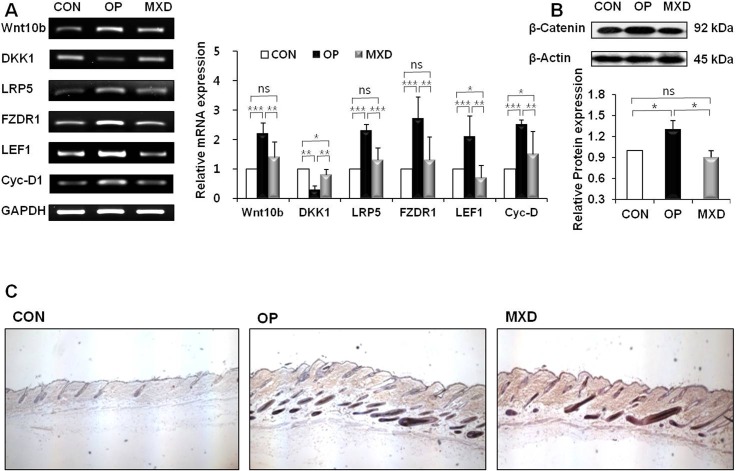
Effect of oleuropein on expression of genes related to hair growth in C57BL/6N mice skin tissue.(A) The Wnt10b, DKK1, LRP5, FZDR1, LEF1, and Cyc-D1 mRNA expression levels were measured by RT-PCR. A representative image of triplicate experiments is shown in the left panel. The right panel shows the intensity of the bands that were densitometrically measured and normalized against the mRNA expression level of GAPDH. (B) The protein level of β-catenin in C57BL/6N mouse skin tissue was determined by western blotting. The lower panel shows the intensity of the bands that were densitometrically measured and normalized against the protein level of β-actin. (C) Immunohistochemical analysis of β-catenin in hair follicles. Original magnification: 40×. Western blotting and RT-PCR results are the mean (n = 8) ± SD of three independent experiments (n = 2 or 3 per experiment) for each group. ns = p > 0.05, * = p < 0.05, ** = p < 0.01, *** = p < 0.001 (one-way ANOVA, Tukey's test).